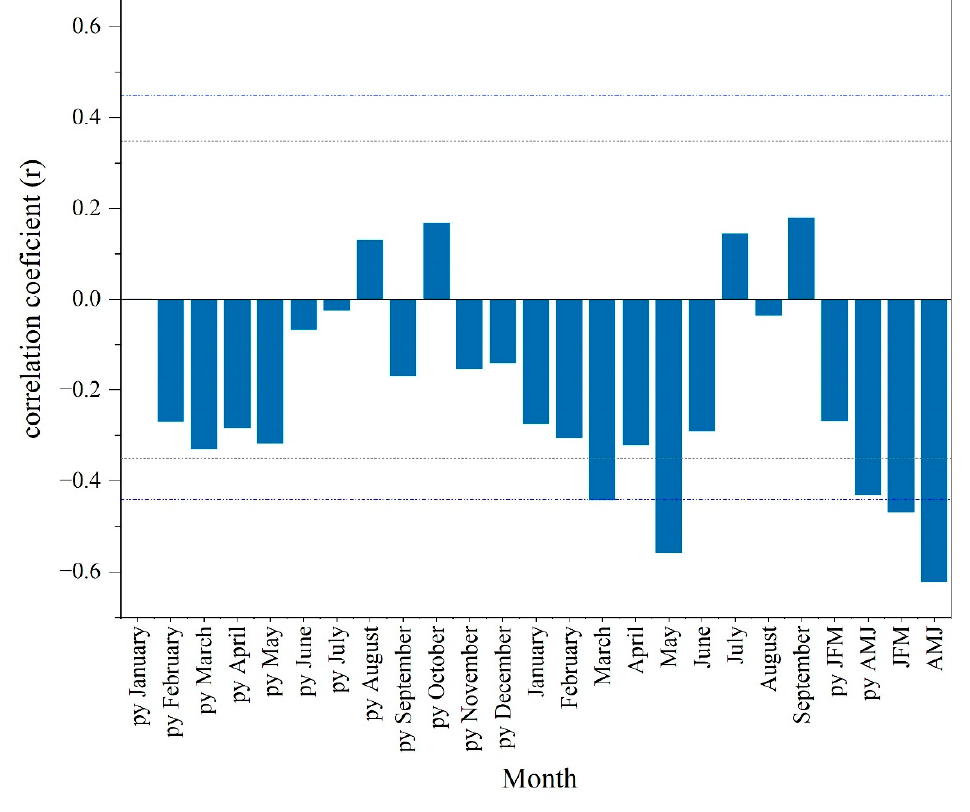
Figure 3. Correlations between tree-ring δ 18 O and monthly and seasonal precipitation during the period 1982–2015. Correlations were calculated for a 21-month period from January of the previous year (py January) until September of the current year, and seasonally averaged data of the previous (January. February. March, as previous winter: py JFM; April. May. June, as previous spring: py AMJ) and current (January. February. March, as winter: JFM; April. May. June, as spring: AMJ) years. Gray and blue horizontal lines indicate significance levels at p < 0.05 and p < 0.01, respectively.